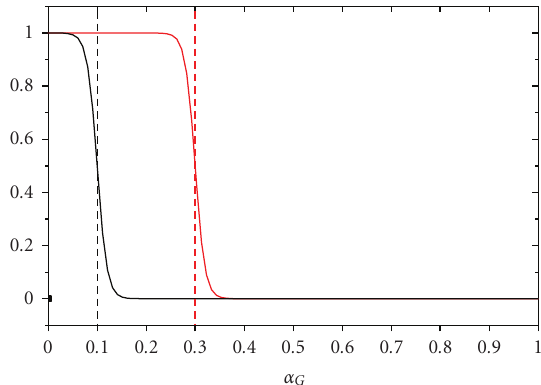
Figure 13: Blending function f according to (21) for α 0 = 0 . 1 (black curve) and α 0 = 0 . 3